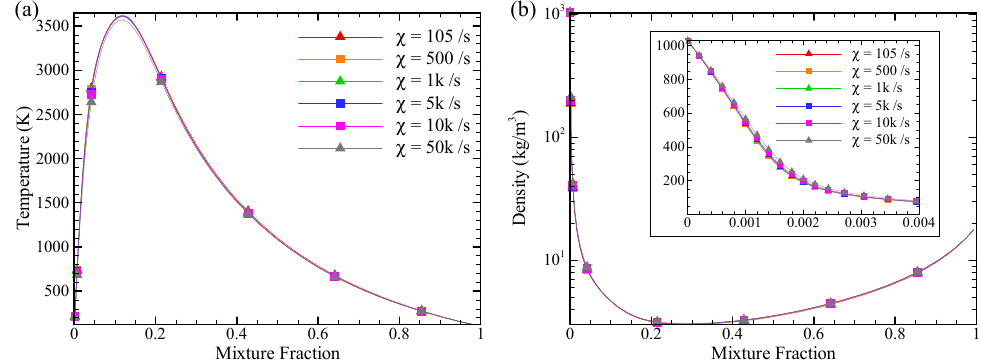
Figure 5. Plots of the mixture fraction verses ( a ) temperature, ( b ) density from generated flamelet table. The x -axis of the zoomed-in frame in plot ( b ) is reset to 0–0.004. The range of scalar dissipation rate (SDR) for both plots is 105–50,000.